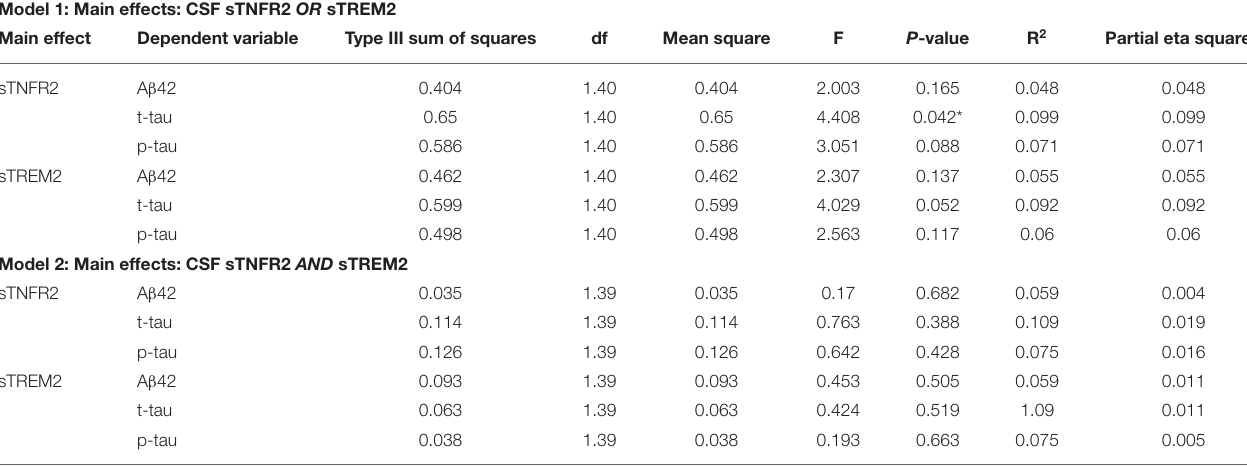
TABLE 4 | Key results of the general linear model with CSF A β 42, t-tau, and p-tau as the dependent variables and covariates: age, sex, education, APOE ε 4 status, among participants from the Alzheimer’s Disease Neuroimaging Initiative cohort with Alzheimer’s disease dementia (participants meeting A + T + criteria). Model 1: Main effects: CSF sTNFR2 OR